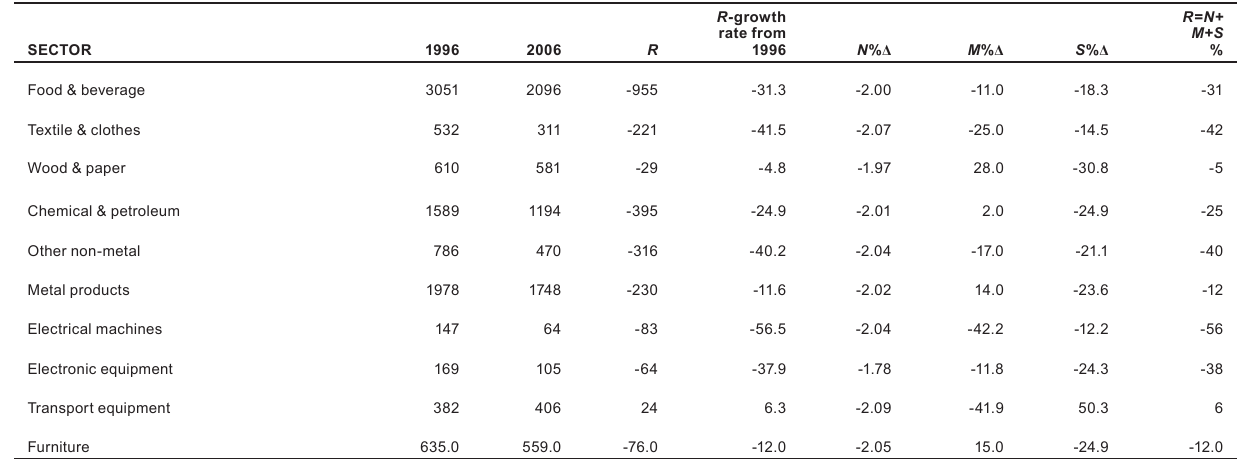
TABLE 6 Percentage contribution to the relevant